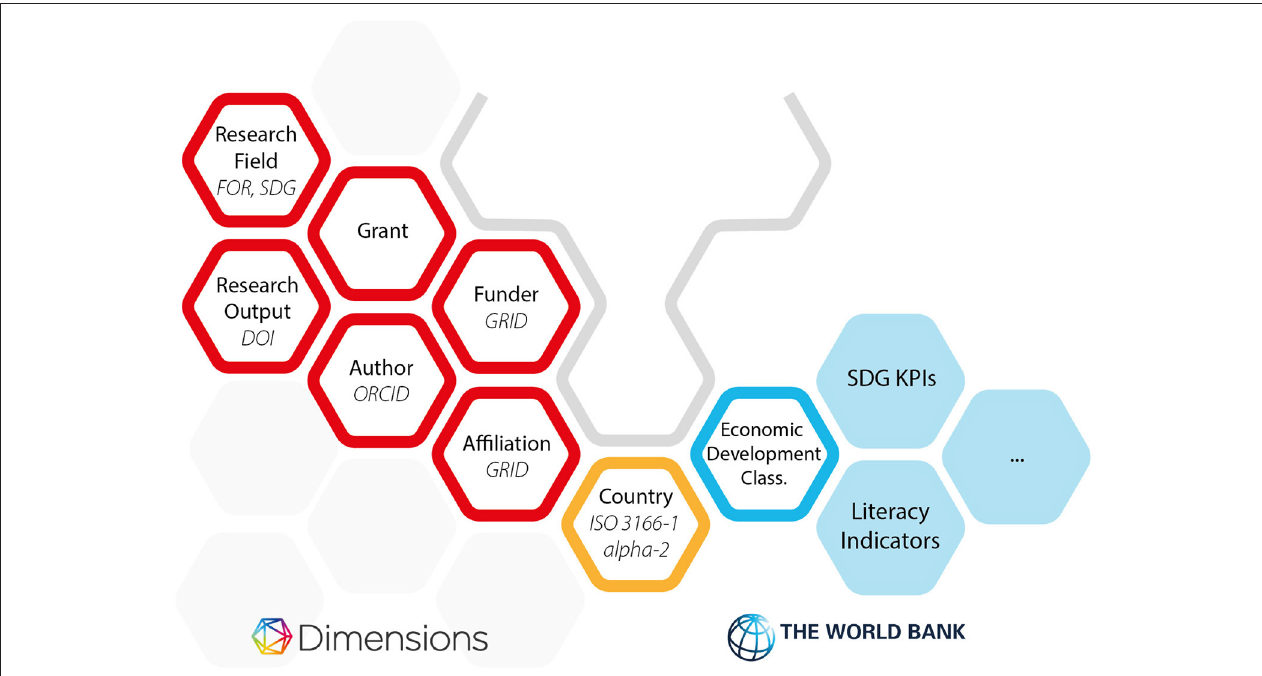
FIGURE 2 | High-level entity diagram showing the objects in the Google Big Query environment that support Listing 1 . Hexagons outlined in red are those contained in the Dimensions dataset. Hexagons outlined in blue are the data from the World Bank Dataset that are used in this article. Hexagons in solid blue are other hexagons in the World Bank Dataset that haven’t been used in this article but which could be of significant interest in further studies. The hexagon outlined in gold is the data that appears in both dataset allowing the link and contextualization that we explore in this article. For those wishing to explore this further, Dimensions has released a free COVID-19 dataset on the Google Cloud Marketplace, which has identical structure to the main